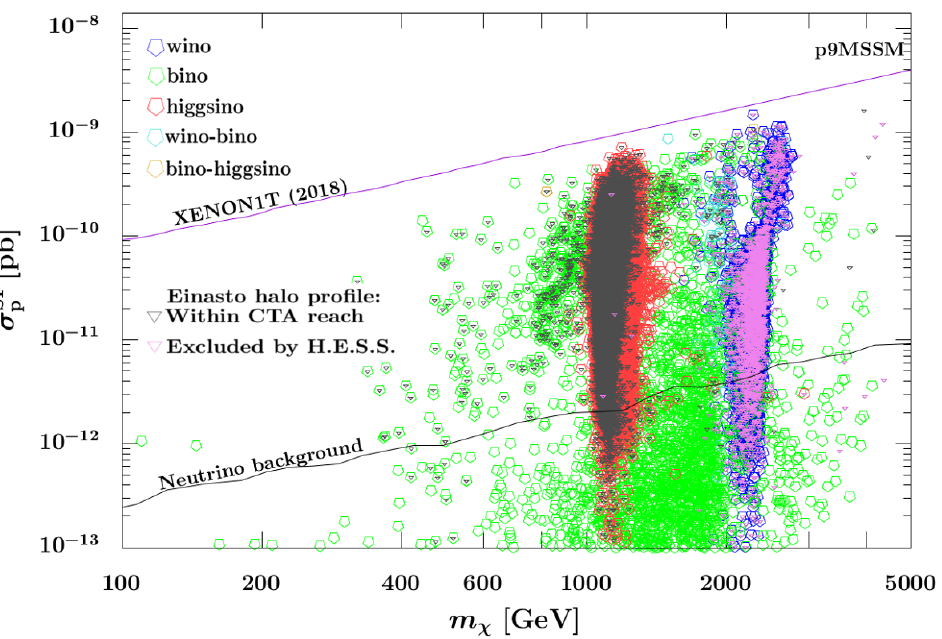
Figure 3. Distribution of p9MSSM points with (cid:1) (cid:31) 2 coding as in (cid:12)gure 2. Points excluded by H.E.S.S. (Einasto, both continuous and monochromatic photon search) are denoted by violet triangles, while those within the sensitivity of CTA (Einasto, both continuous and monochromatic photon search) are denoted by black triangles. The most recent limit from the XENON1T Collaboration [93], which is included in the likelihood function, is denoted by a purple solid line, while the onset of the irreducible neutrino background is denoted by a black solid